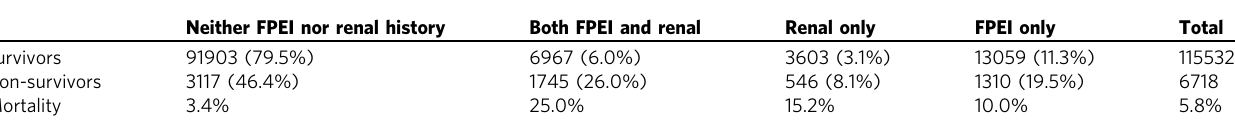
Table 2 Mortality rates of patient cohorts with or without a prior history of fl uid, pH and electrolyte imbalance (FPEI), and/or renal comorbidities. Neither FPEI nor renal history Both FPEI and renal